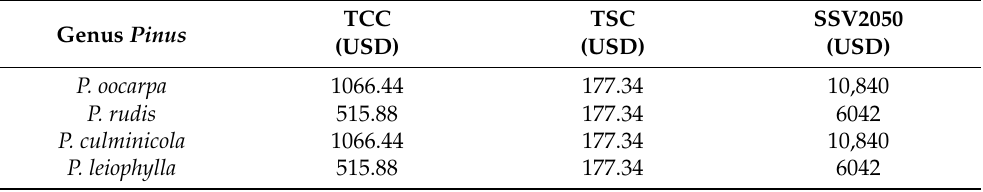
Table 9. Value of seeds stored in the FESI-BS by the year 2050.